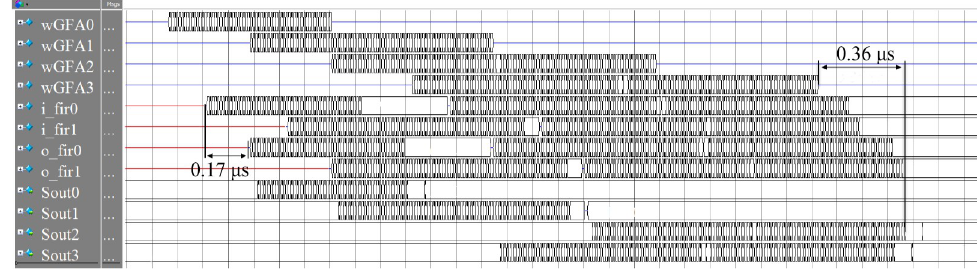
Fig 13. Pre-synthesis simulation results.